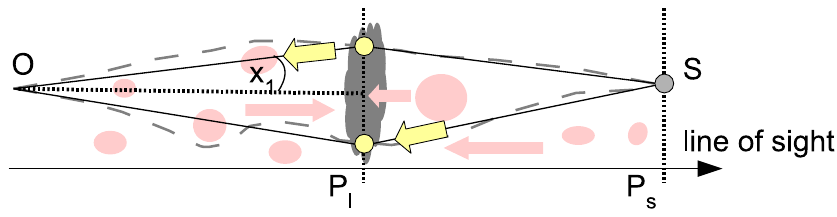
Figure 1. Strong gravitational lenses can cause a deflection of light rays from a source S (grey circle) in the source plane P s into two images (yellow circles) in the lens plane P l . The upper image is observed at the angular position x 1 on the sky. The deflecting mass density (grey cloud) is assumed to consist of all masses along the line of sight (red circles) projected into P l , such that the light deflection is assumed to happen instantaneously at P l and not at the individual masses (as indicated by the grey dashed paths). Differences in the arrival times of the light rays from the images at the observer O (indicated by the yellow arrows) occur due to the different light